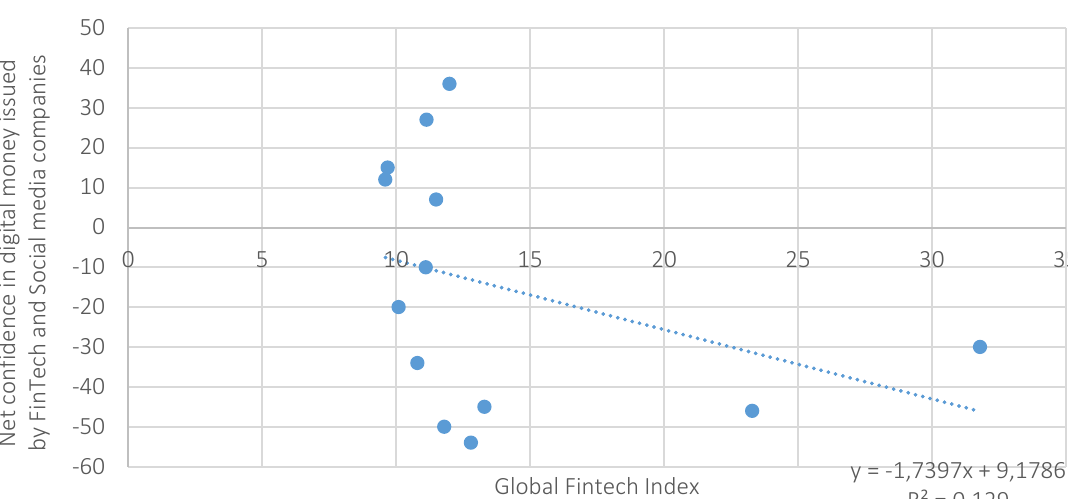
Figure С3. Confidence in privately issued digital money and innovations